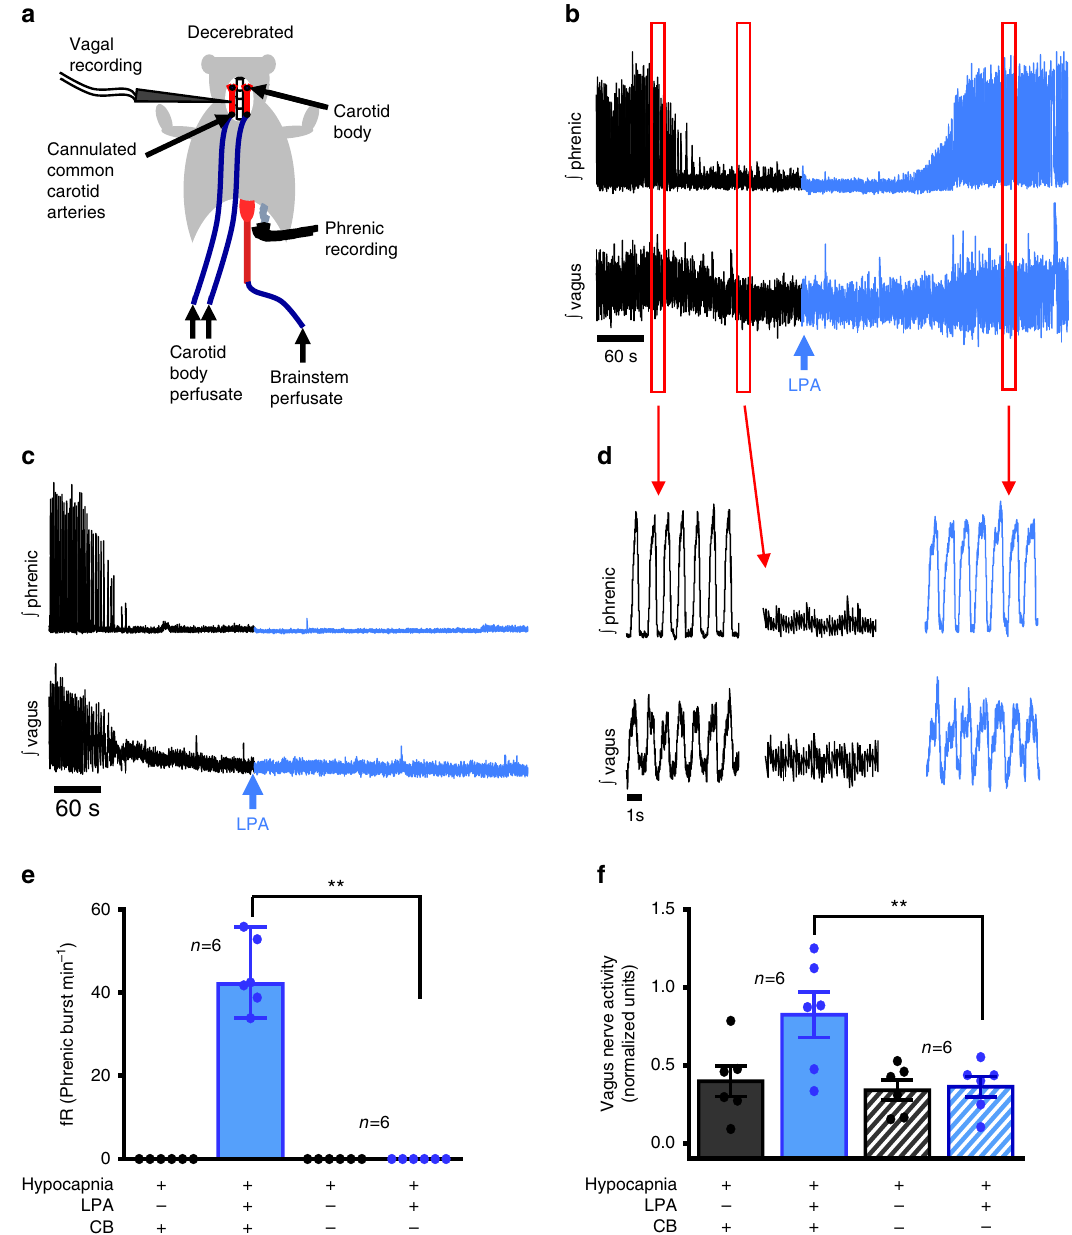
Fig. 2 LPA stimulation of the carotid body increases efferent vagal activity. a The dual perfused in situ preparation used to record phrenic and vagal activity in response to speci fi c carotid body stimulation. b Phrenic (upper trace) and vagal (lower trace) activity with the carotid body intact under brainstem hypocapnia (black trace) causing cessation of phrenic fi ring (neural apnea) and vagal quiescence. Activity is restored following carotid body stimulation with 5 µ M LPA (blue arrow/trace), with restoration of vagal activity. c In denervated preparations the stimulatory effect of LPA on vagal and phrenic activity is absent. d Expanded sections of traces from b indicated by the red boxes, illustrating phrenic and vagal activity prior to brainstem hypocapnia induced apnea, apnea and following LPA injections. e , f Summary data during hypocapnia in intact (solid) and carotid body (CB) denervated (crossed) preparations for phrenic frequency (Phrenic burst min − 1 ; Mann Whitney: U = 0, p = 0.002, ** median ± range) and vagal total activity (normalized to baseline normoxic activity, normalized units, independent t test: t 10 = 4.008, p = 0.0025, ** mean ±